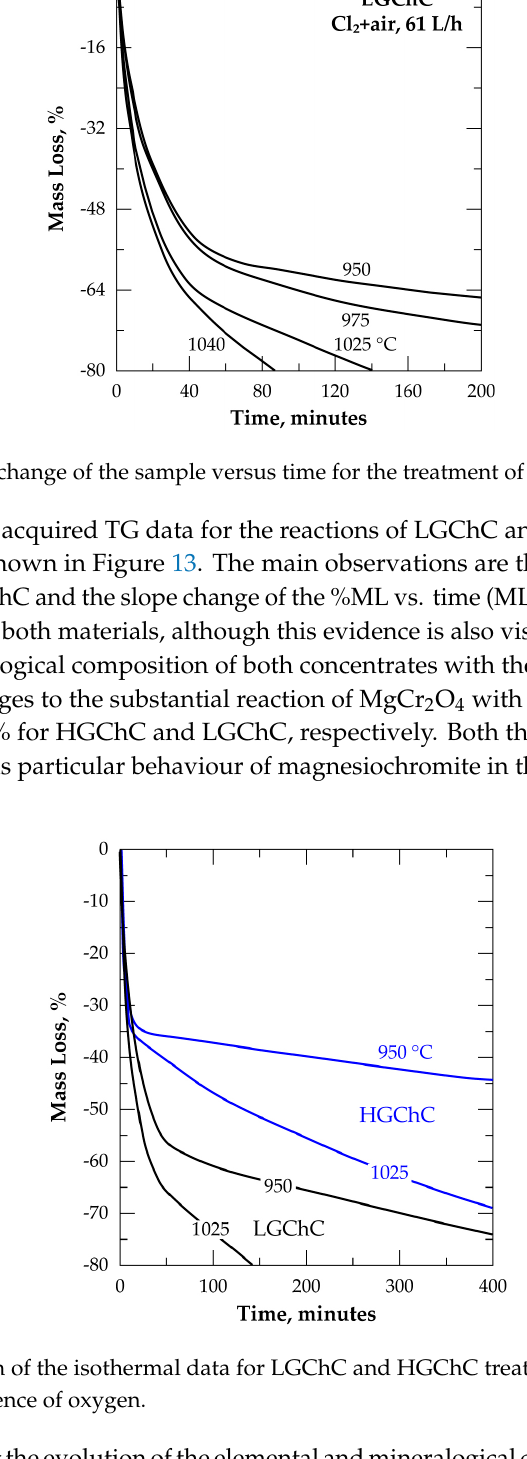
Figure 14. SEM-EDS results of residue from the oxychlorination of HGChC at different α -values.